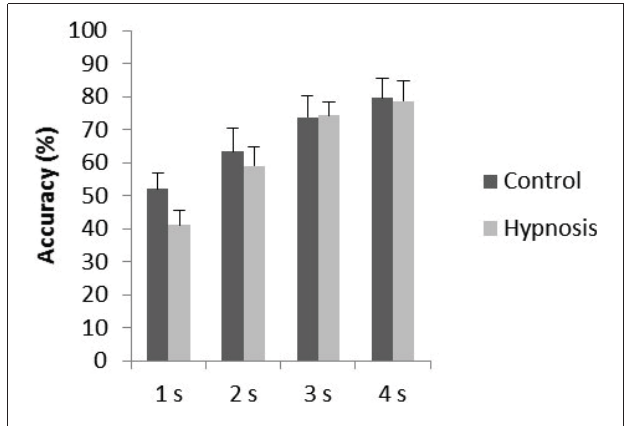
FIGURE 3 | Shape detection accuracy for control and hypnosis conditions across stimulus durations (1–4 s). Error bars represent 1 SEM.